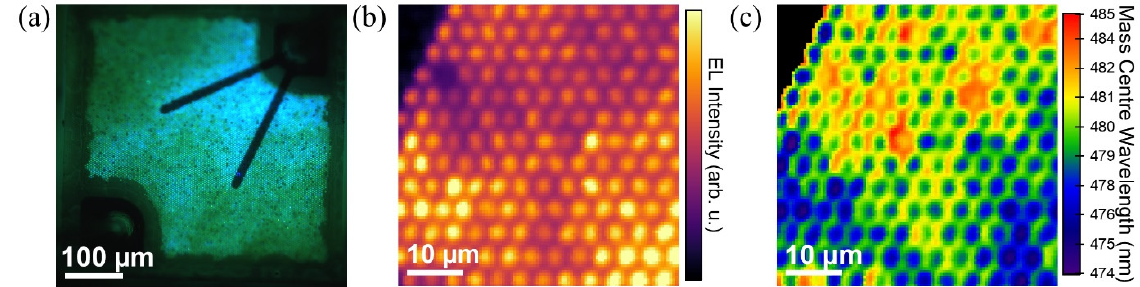
Figure 5. ( a ) EL image of a microrod LED at 4 V. Reprinted with permission from Ref. [46]. Copyright 2021 AIP Publishing. ( b ) Maximum EL intensity map of microrod LED at 3.6 V [47]. ( c ) Corresponding mass center wavelength map at 3.6 V [47].